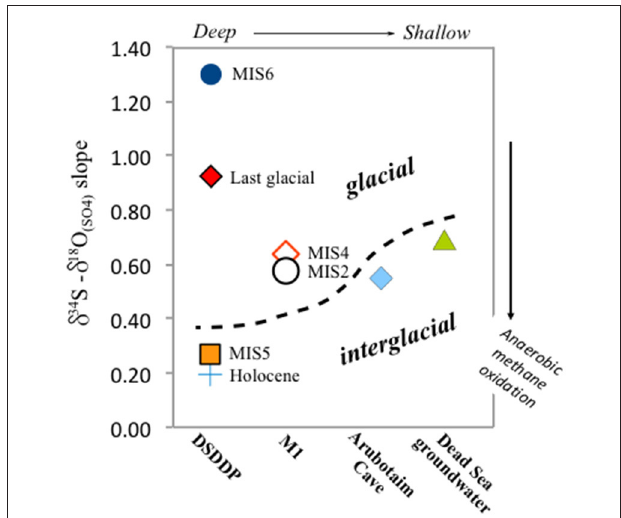
FIGURE 9 | Slope values between δ 34 S and δ 18 O ( SO 4) from different time intervals at different sites.